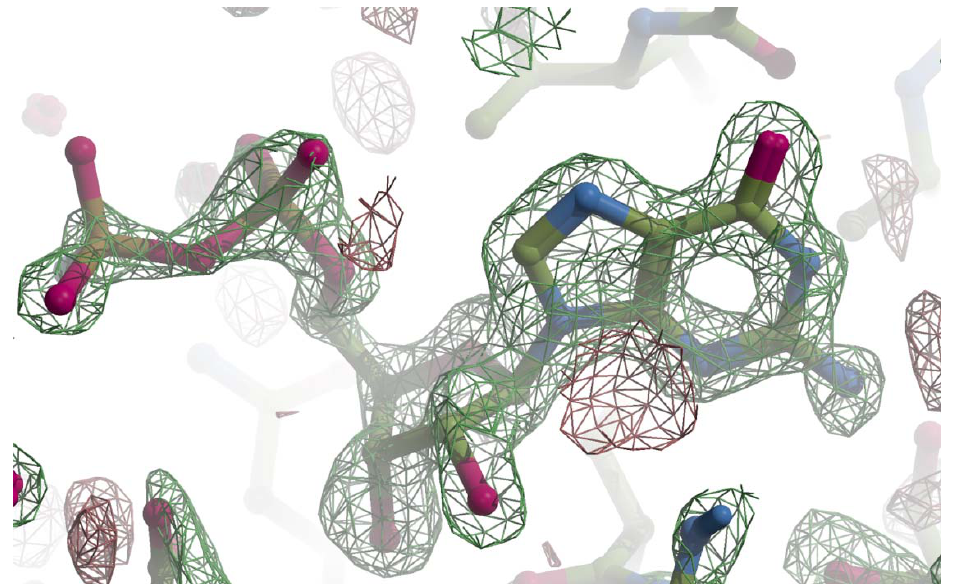
Figure A1. The Fo-Fc omit map for GMPPN. The Fo-Fc map was calculated with phases from the molecular replacement solution and drawn with Crystallographic Object-Oriented Toolkit (COOT) [22]. The final refined model was superimposed on the Fo-Fc map with a ball-and-stick model with the following colors; carbon is shown in green, oxygen pink, nitrogen blue, and phosphorus brown. The positive contour at 3.5 σ is represented with a green net and the negative with red.